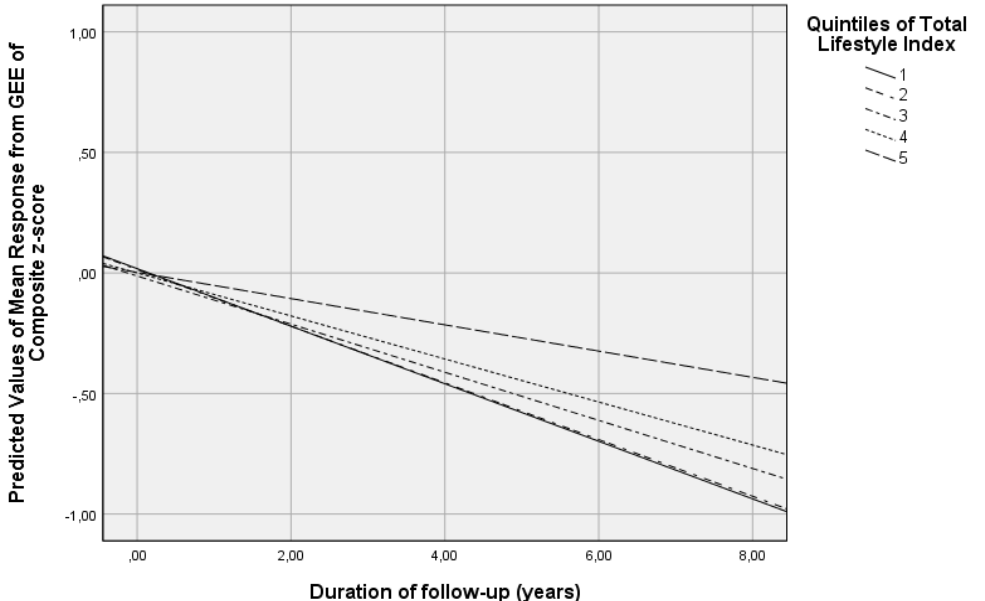
Figure 1. Results from Generalized Estimating Equations assessing the associations between the quintiles of the Total Lifestyle Index (independent variables) with differential rates of the Global Cognition score over time (dependent variables) in non-demented participants at baseline ( p for trend < 0.001). All models were adjusted for age, sex and years of education. TLI was associated with a significantly lower risk for dementia development. For each additional unit of the TLI, the risk for dementia was reduced by 0 .2% per year of follow-up. In detail, participants in the highest quintile of the TLI (highest scores) had 3.7% less risk for developing dementia per year of follow -up compared with those in the lowest quintile, with a significant trend for a dose–response association (Table 3).